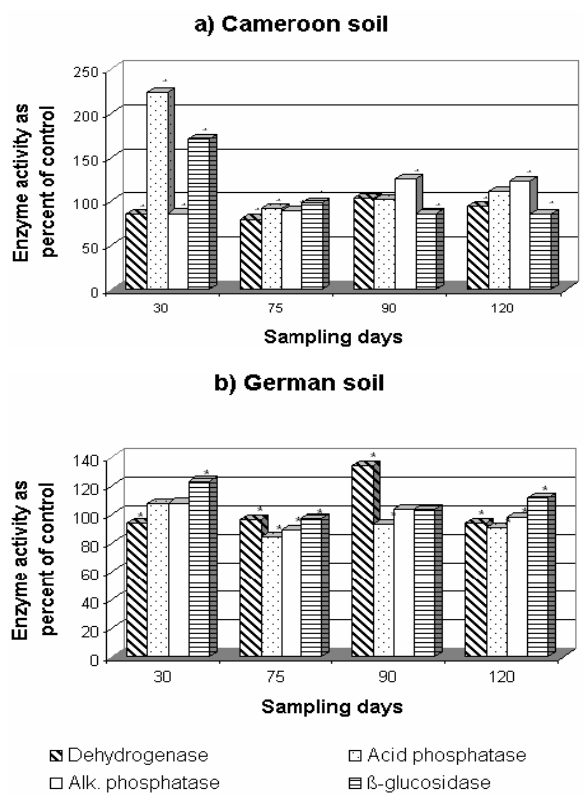
Figure 8: Effect of F-metalaxyl on enzyme activities in the Cameroonian (a) and German (b) soils. * P <0.05 between fungicide addition and no fungicide addition (paired Student t-test).